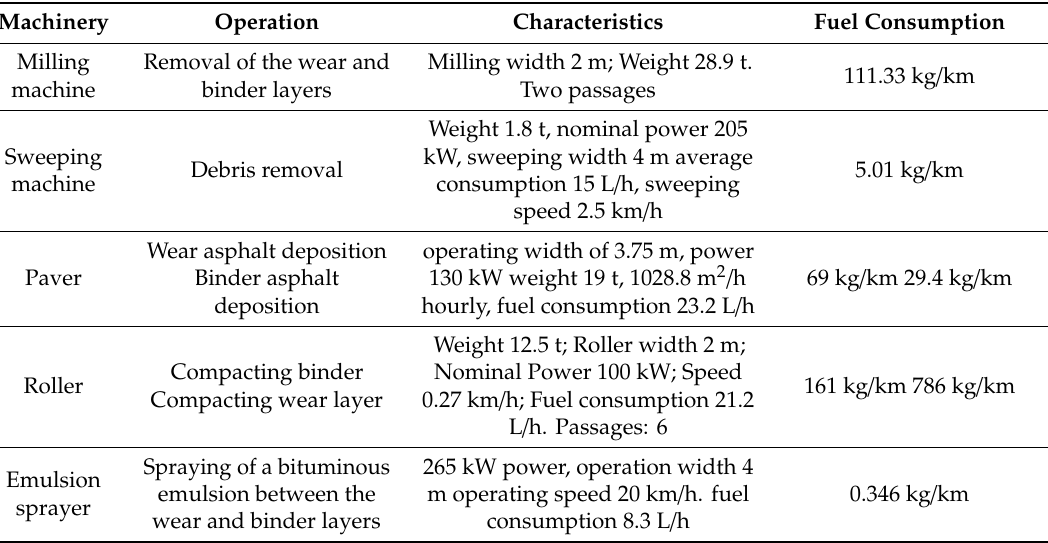
Table 6. The technical data of the considered